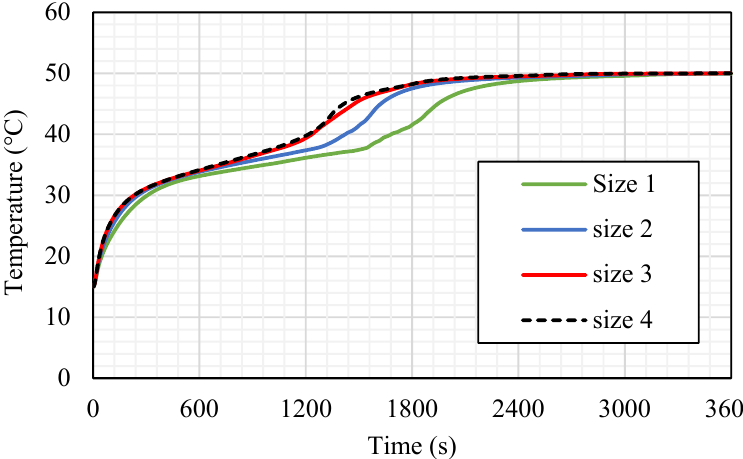
Figure 13. The liquid fraction development for the total PCM for the cases (case 3 (size 1: 2 × 7.071 mm 2 ), case 3a (size 2: 1 × 14.14 mm 2 ), case 3b (size 3: 0.666 × 21.21 mm 2 ), and case 3c (size 4: 0.55 × 25.76 mm 2 )).